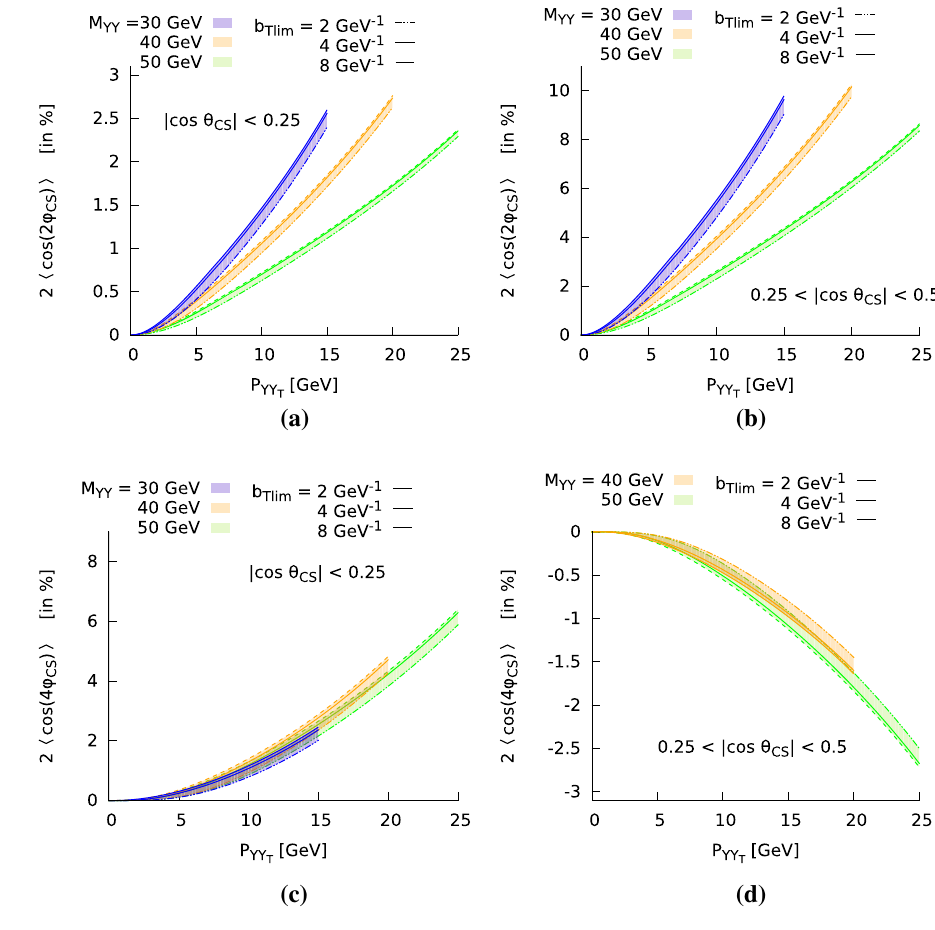
Fig. 6 The azimuthal asymmetries for di- ϒ production as functions of P QQ T . The different plots show 2 (cid:13) cos ( 2 φ CS ) (cid:14) (top) and 2 (cid:13) cos ( 4 φ CS ) (cid:14) (bottom), at | cos (θ ) | < 0 . 25 (left) and at CS 0 . 25 < | cos (θ CS ) | < 0 . 5 (right). Results are presented for M ϒϒ = 30, 40 and 50 GeV, and for b T lim = 2, 4 and 8 GeV − 1